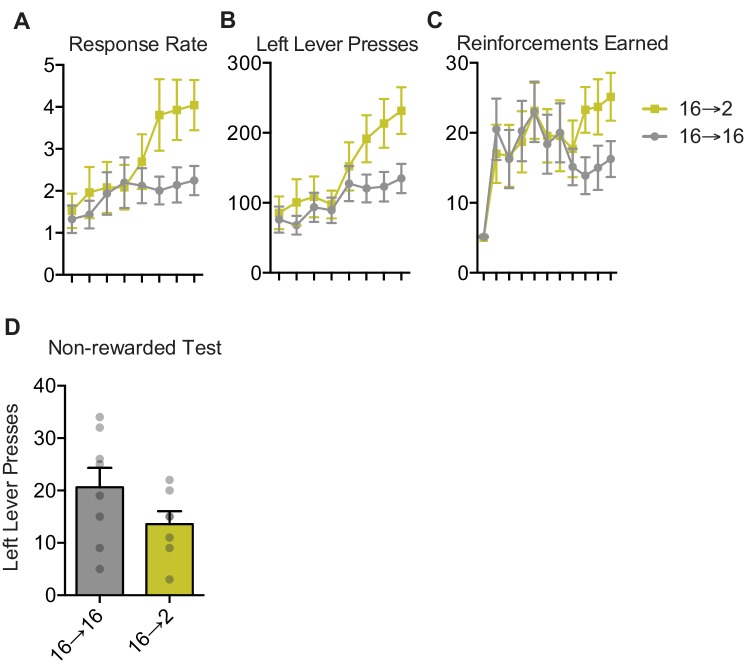
Acquisition of lever pressing for negative incentive learning.(A) Responses per minute during training days on the left lever for negative incentive learning group. Two-way ANOVA: interaction (F (7,91)=3.97, p=0.0008); no effect of group; main effect of training day (F (7, 91)=9.64, p<0.0001). (B) Left lever presses for each training day for negative incentive learning. Negative incentive learning: interaction: F (7,91)=3.29, p=0.0036; no effect of group; main effect of training day: F (7,91)=16.14, p<0.0001. (C) Sucrose outcomes earned each training day for negative incentive learning. Negative incentive learning: no interaction; no effect of group; main effect of training day: F (10,130)=7.77, p<0.0001. (D) Left lever presses on non-rewarded test day for negative incentive learning. Unpaired t-test: F = 2.58, p=0.1489.